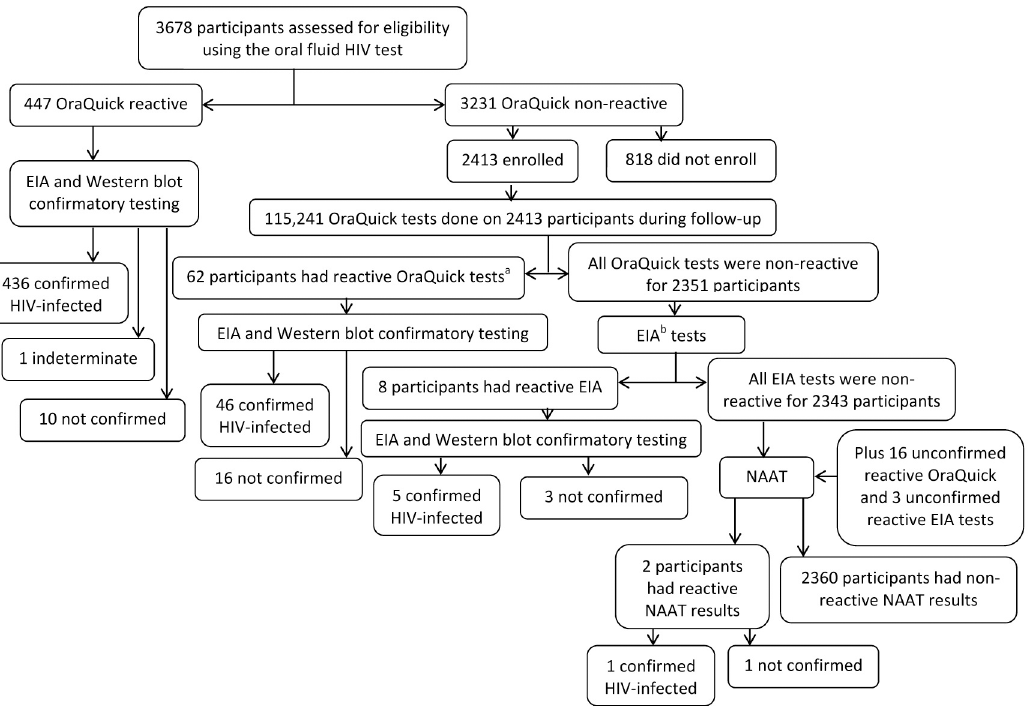
Fig 1. HIV test results of participants in the Bangkok Tenofovir Study, 2005 – 2012. OraQuick, OraQuick Rapid HIV-1/2 Antibody Test; EIA, enzyme immune assay; NAAT, nucleic-acid amplification test. a Two participants with reactive OraQuick tests during follow-up were later found to have been HIV- infected before enrollment. b Plasma collected at 3-monthly visits from participants with a non-reactive OraQuick test result was tested for HIV using EIA.